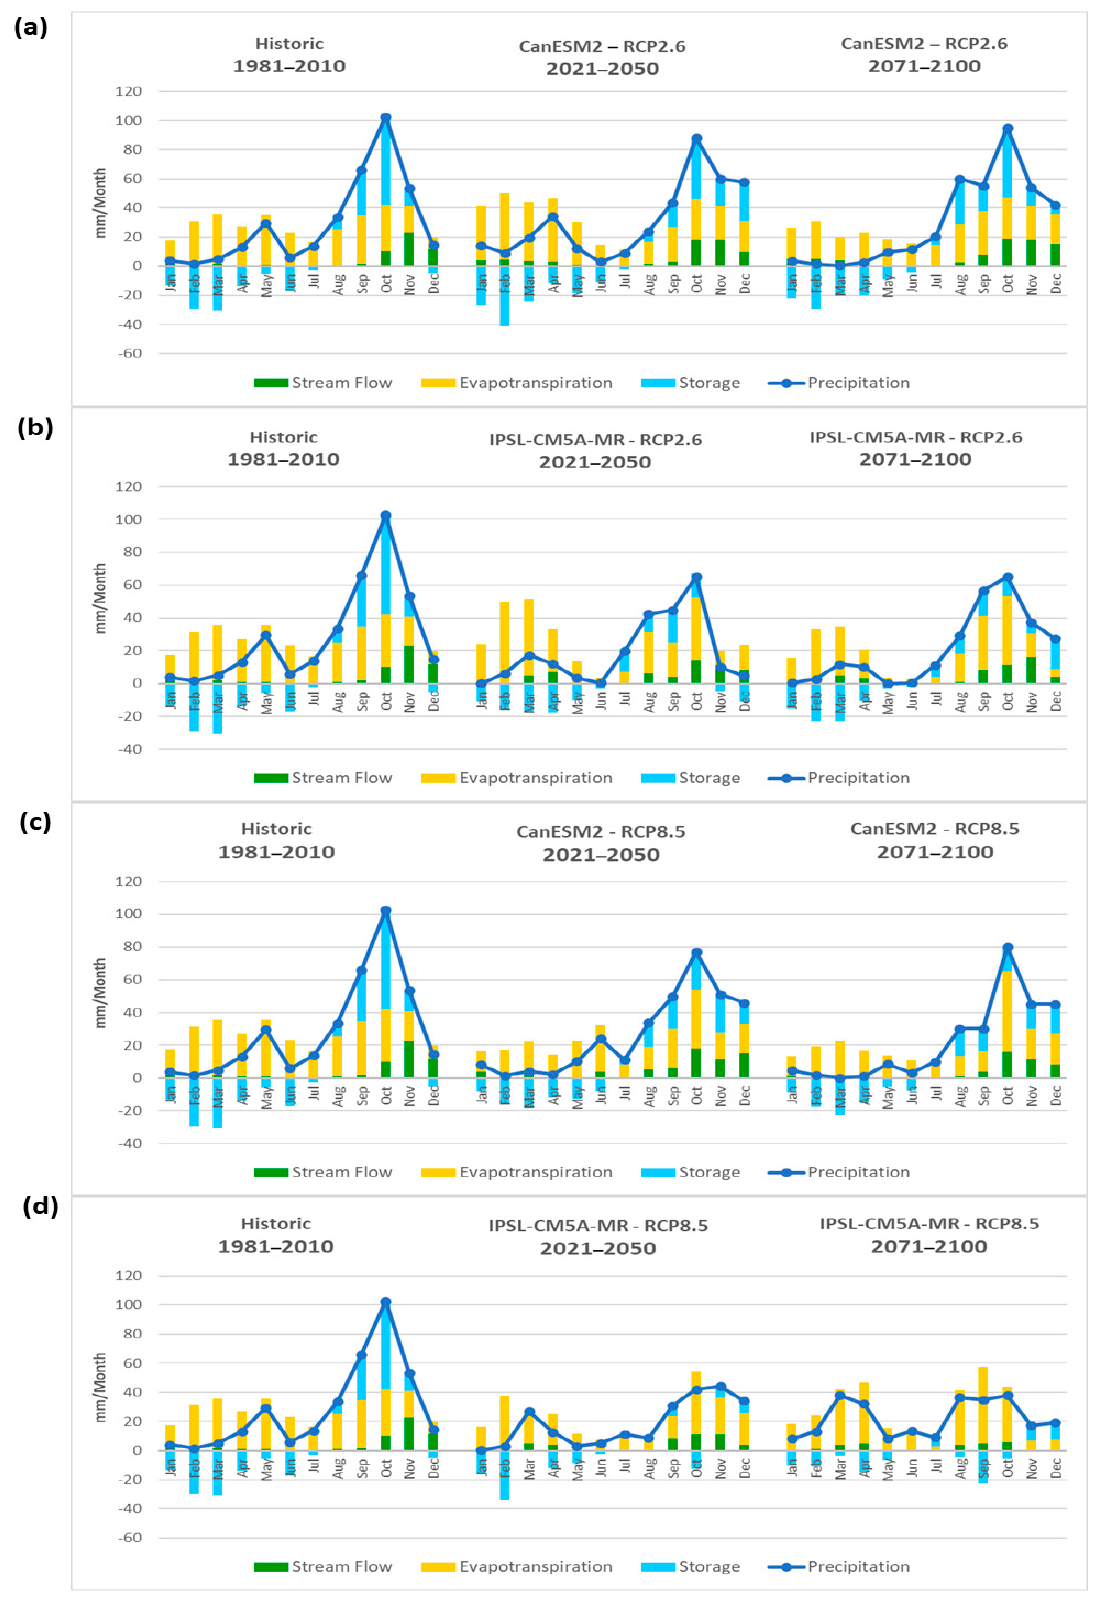
Figure A1. Alta Figure A1. Alta Guajira